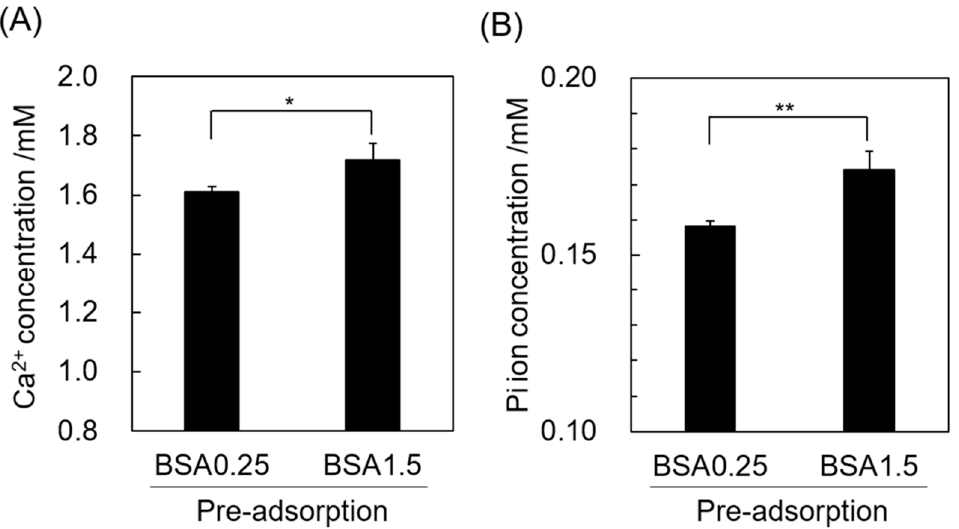
Figure 9. Ca 2 + ( A ) and Pi ion ( B ) concentration in the Ca3.0P1.0 solution without BSA after incubation of OCP with pre-adsorbed BSA in the Ca3.0P1.0 solution containing 0.25 or 1.5 mg · mL − 1 BSA. Mean values were obtained from three independent experiments (n = 3). * p < 0.05, ** p < 0.01 significant difference.